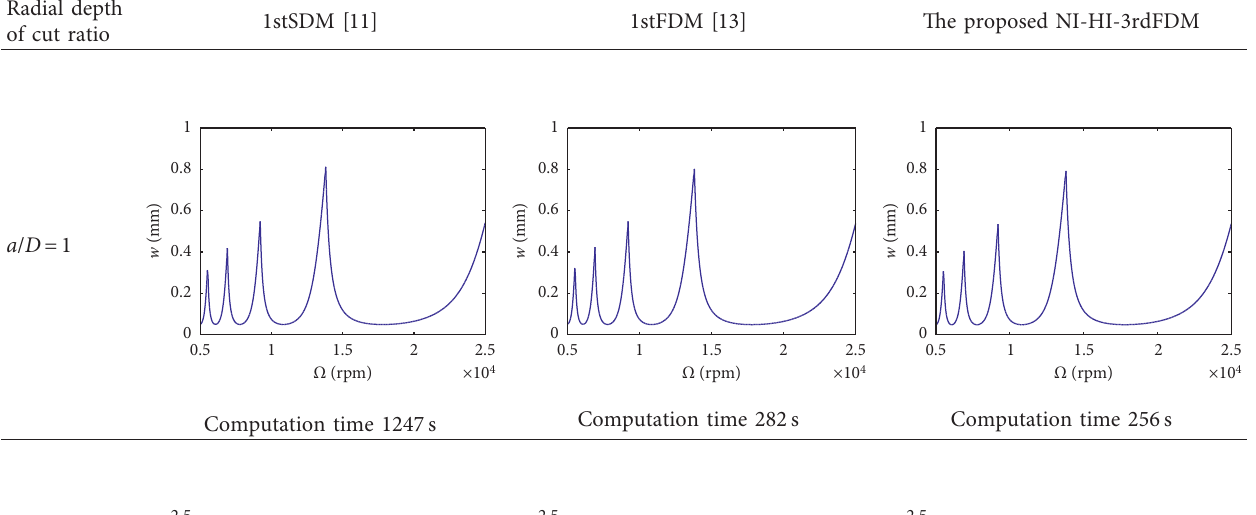
Table 4: SLD for the two-DOF milling model using the 1stSDM, 1stFDM, and the proposed NI-HI-3rdFDM. Radial